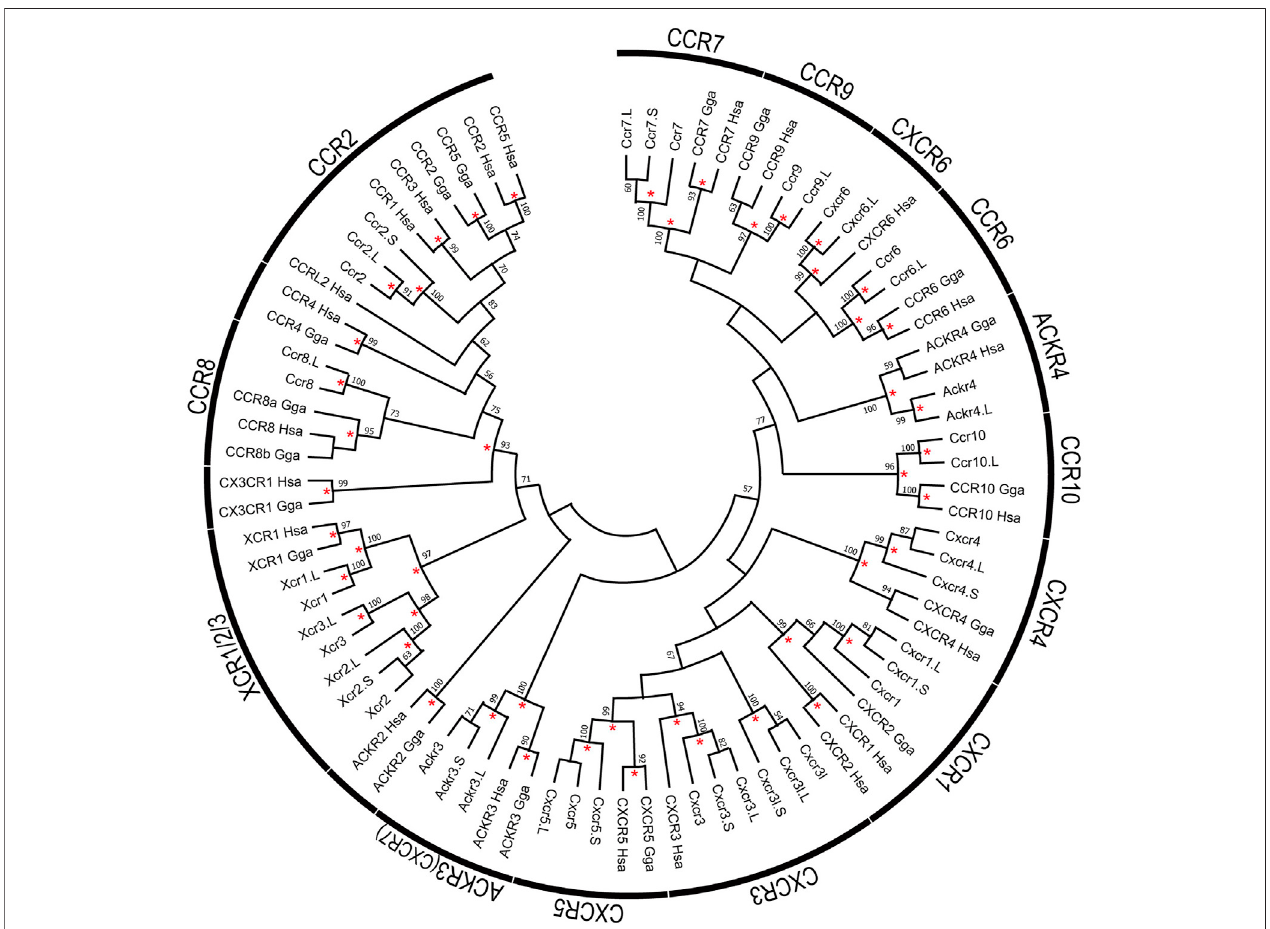
FIGURE 4 | Phylogenetic tree of chemokine receptors. The tree indicates 82 chemokine receptor proteins, including 26 of X. laevis , 17 of X. tropicalis , 17 of G. Gallus ,and22of H.sapien sgenes.Receptornamesrepresentedonthearcs.Bootstrapvaluesgreaterthan50%wereindicated,andasterisksshowvaluesgreaterthan 90%. The alignment of the receptor proteins was prepared using clustal omega and trimmed manually as 297 peptides with gaps. Maximum likelihood methods were performedwith1,000bootstrapsusingtheJTTmodelwithGammadistributionandinvariantsitesandcompletedeletionofgaps/missingdataandinferenceoption was a nearest-neighbor interchange method on NJ